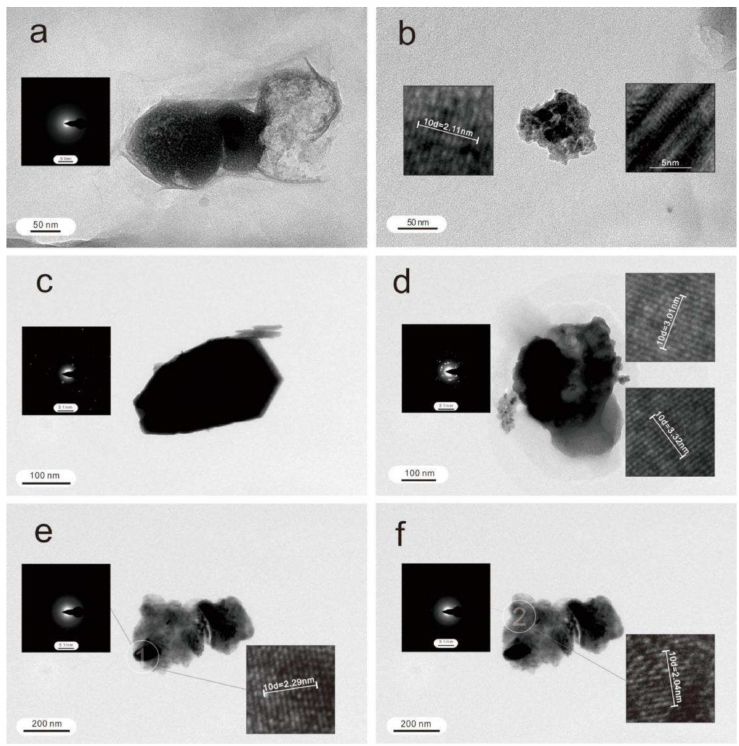
Figure 5. TEM photomicrographs of particles or aggregations in the deep-seated fault gouges. ( a ) TEM image and SAED pattern of an Fe-, As- and Pb-bearing aggregation (ID2). ( b ) TEM image and HRTEM images of a Cu-bearing particle aggregation (ID3). ( c ) TEM image and SAED pattern of a Zn-bearing particle (ID4). ( d ) TEM image, SAED pattern and HRTEM images of a Pb, Zn, As, Fe, and Cu-bearing particle (ID5). ( e , f ) TEM image of a multiple-metal-bearing aggregation. ( e ) SAED pattern and HRTEM image of position 1(ID6). ( f ) SAED pattern and HRTEM image of position 2